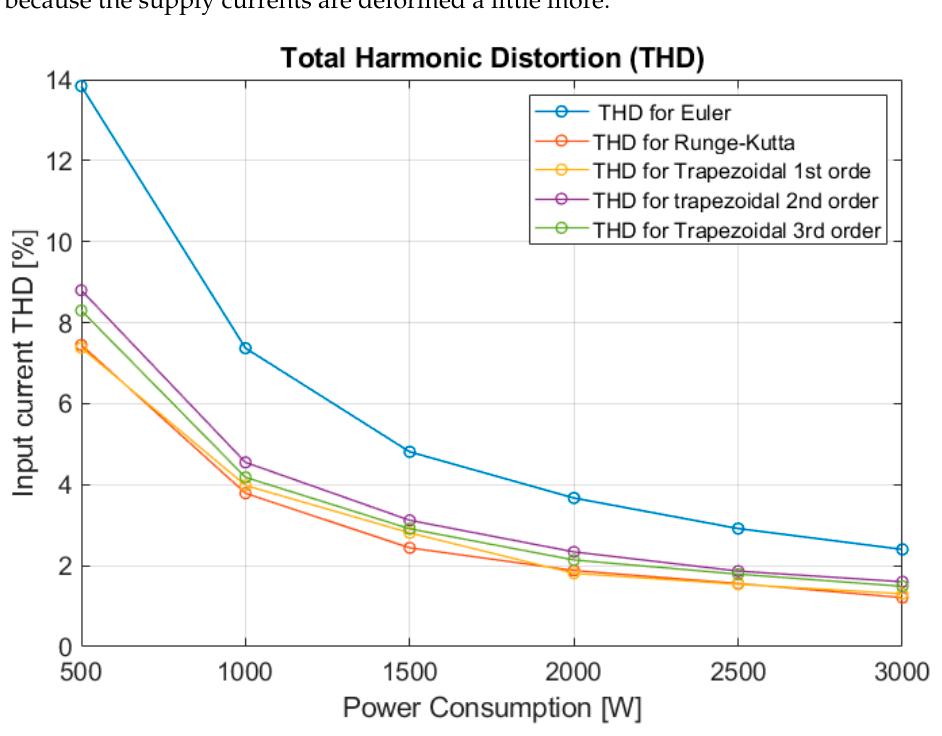
Table 5. Comparison of numerical